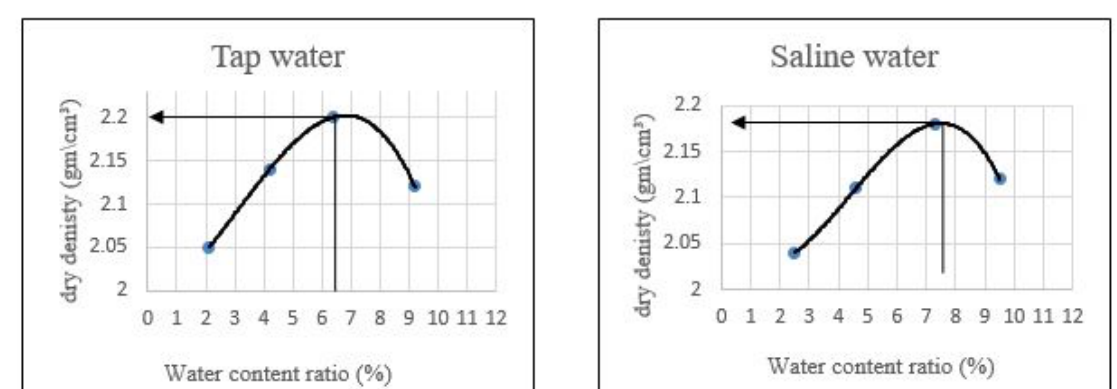
Figure 1. Relation between dry density and water content (modified proctor